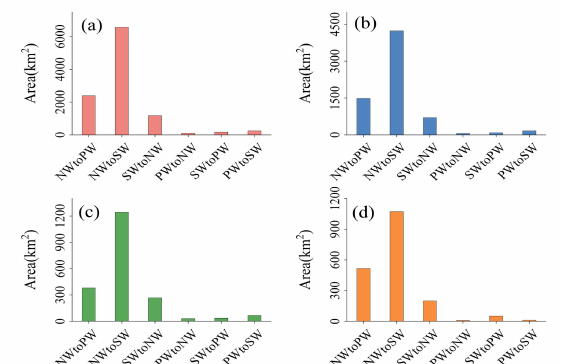
Figure 9. The conversion of open-surface water bodies in the YRB (a) and sub-basins. (b): UYRB; (c): MYRB; (d): LYRB. NW: non-water; PW: permanent water; SW: seasonal water.